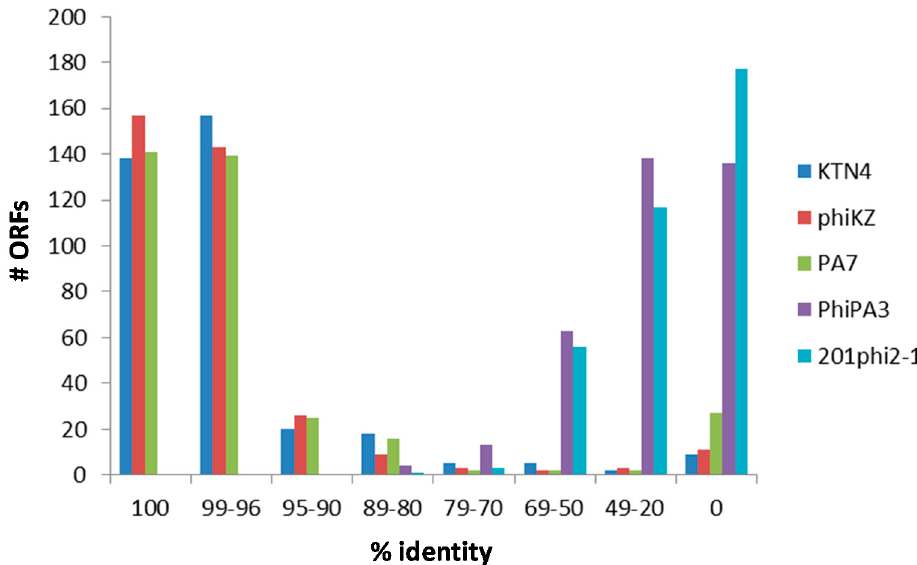
Figure 3. Sequence identity of translated ORFs of phage SL2 with five members of the phiKZ-like viruses (i.e., phages KTN4, phiKZ, PA7, PhiPA3, and 201phi2-1).